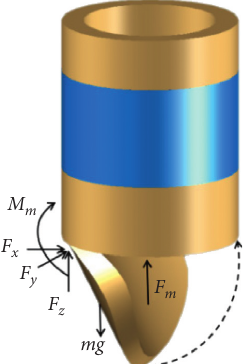
Figure 3: Schematic diagram of the force applied at a certain moment during the valve cover